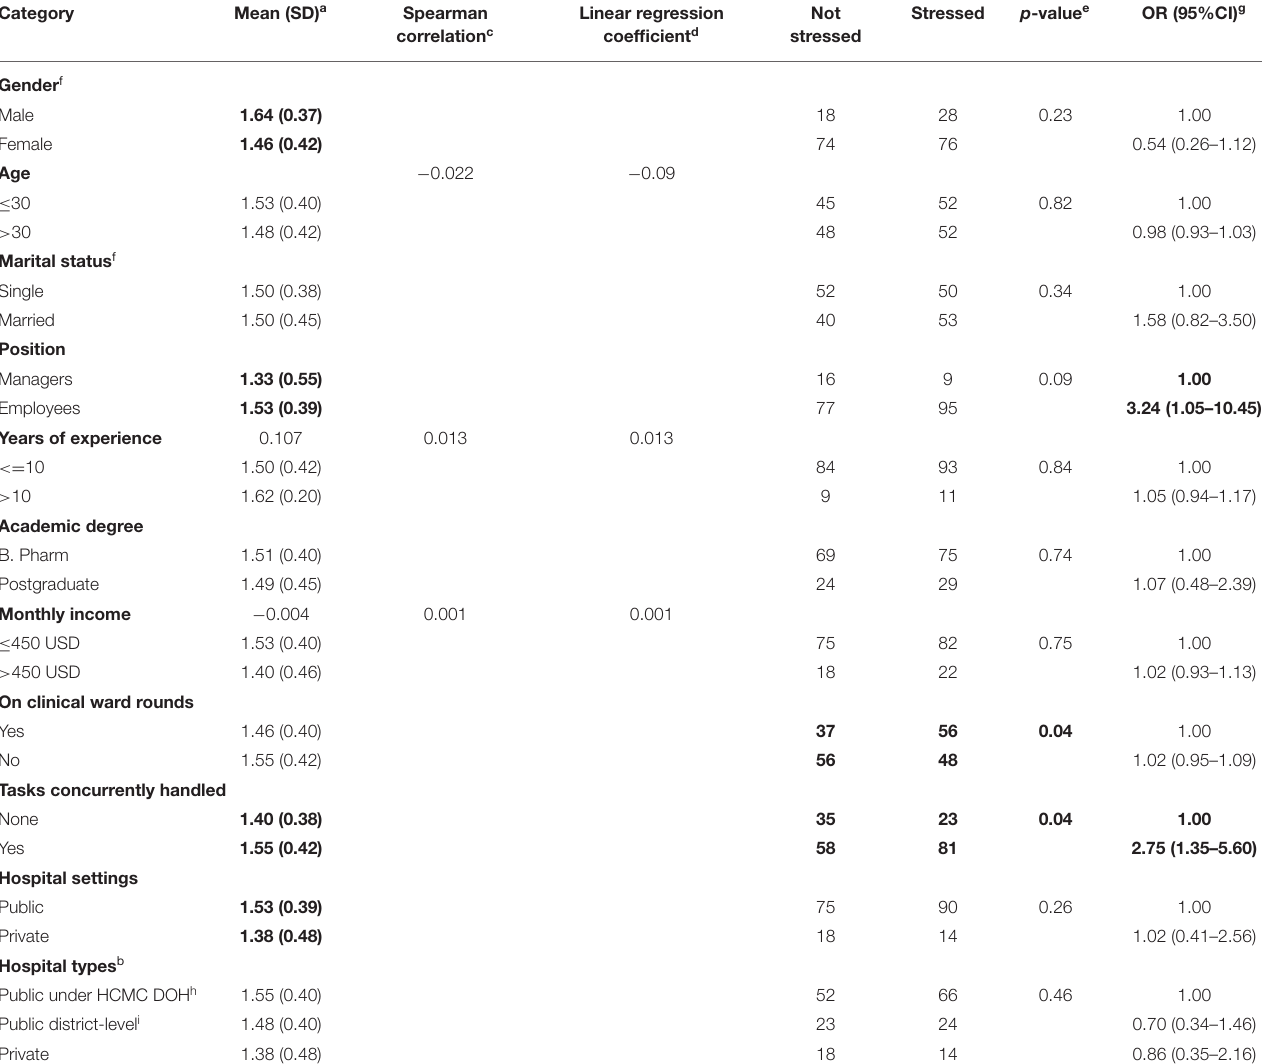
TABLE 4 | Job stress in relation to demographics and professional features. Category Spearman